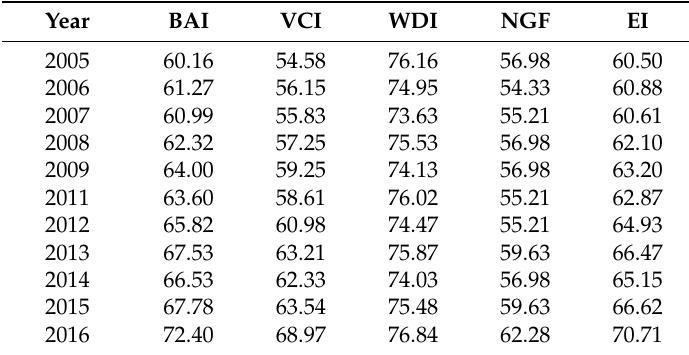
Figure 6. Output energy consumption of the coal mining enterprises in Yuxian.